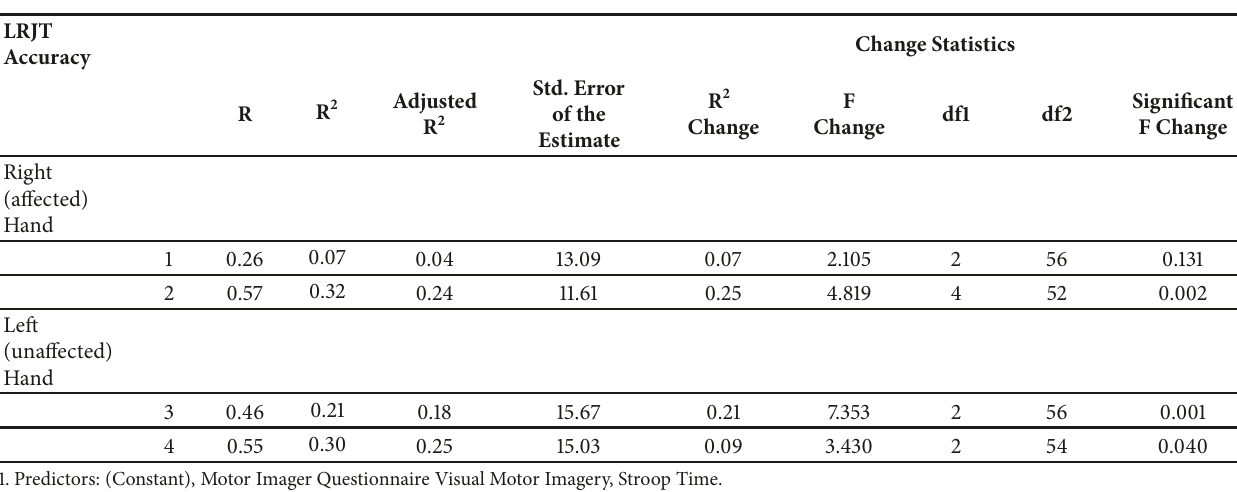
Table 2: Multiple linear regression models for Left Right Judgement Task Accuracy for the